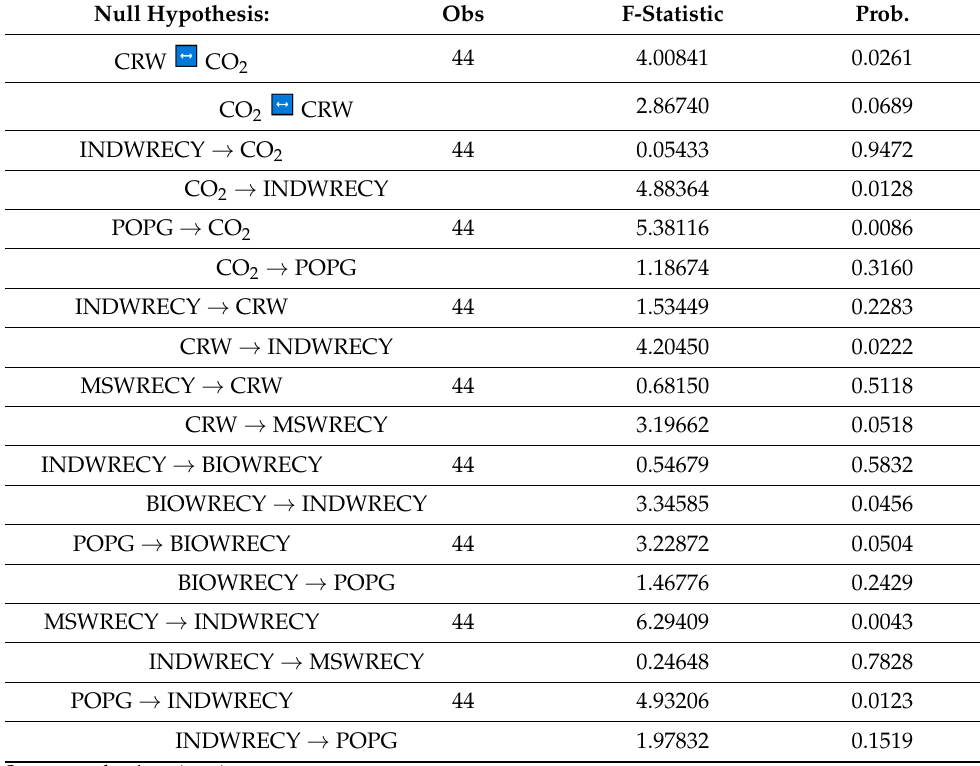
Table 9. Granger Causality Estimates.